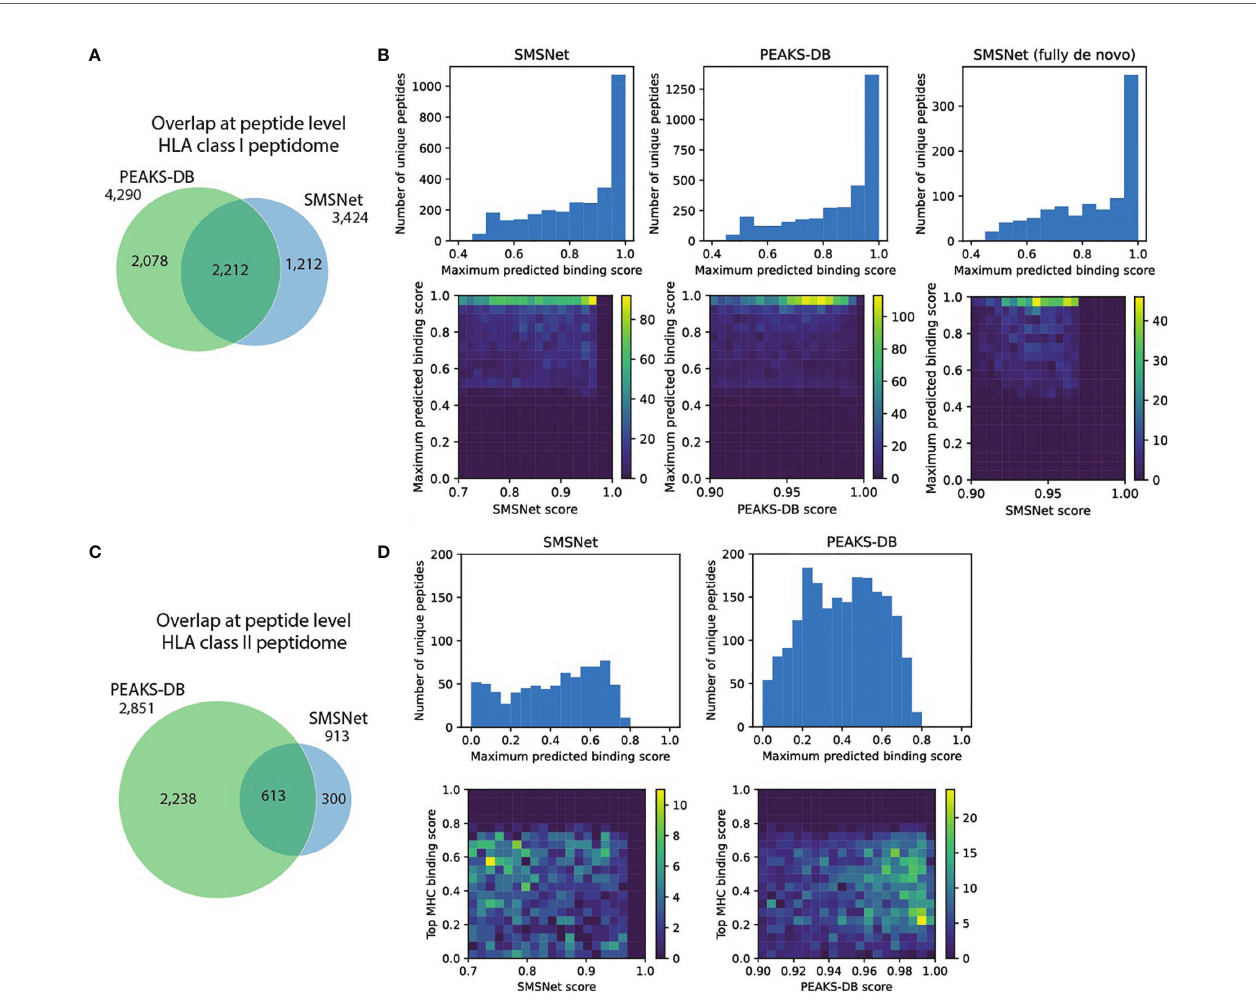
FIGURE 4 | Comparison of SMSNet and PEAKS-DB on multi-allelic B-lymphoblastoid sample. (A) Overlap of identi fi ed peptides from HLA class I peptidomes between SMSNet and PEAKS-DB. (B) Histograms show the distributions of predicted binding scores, calculated as the maximum score over HLA-A*01:01, HLA- B*08:01, and HLA-C*07:01, which are expressed in the cells, for peptides identi fi ed by each tool. Heatmaps show the association between predicted binding scores and peptide identi fi cation con fi dence scores reported by each software. Histogram and heatmap for peptides identi fi ed fully de novo by SMSNet (i.e., without relying on database search step) are also shown separately. (C) Overlap of identi fi ed peptides from HLA class II peptidomes between SMSNet and PEAKS-DB. (D) Similar histograms and heatmaps as in (B) for HLA-DPA1*01:03, HLA-DPB1*04:01/02:01, HLADQA1*05:01/05:01, HLA-DQB1*02:01/02:01, and HLADRB1*03:01/03:01, which are expressed in the